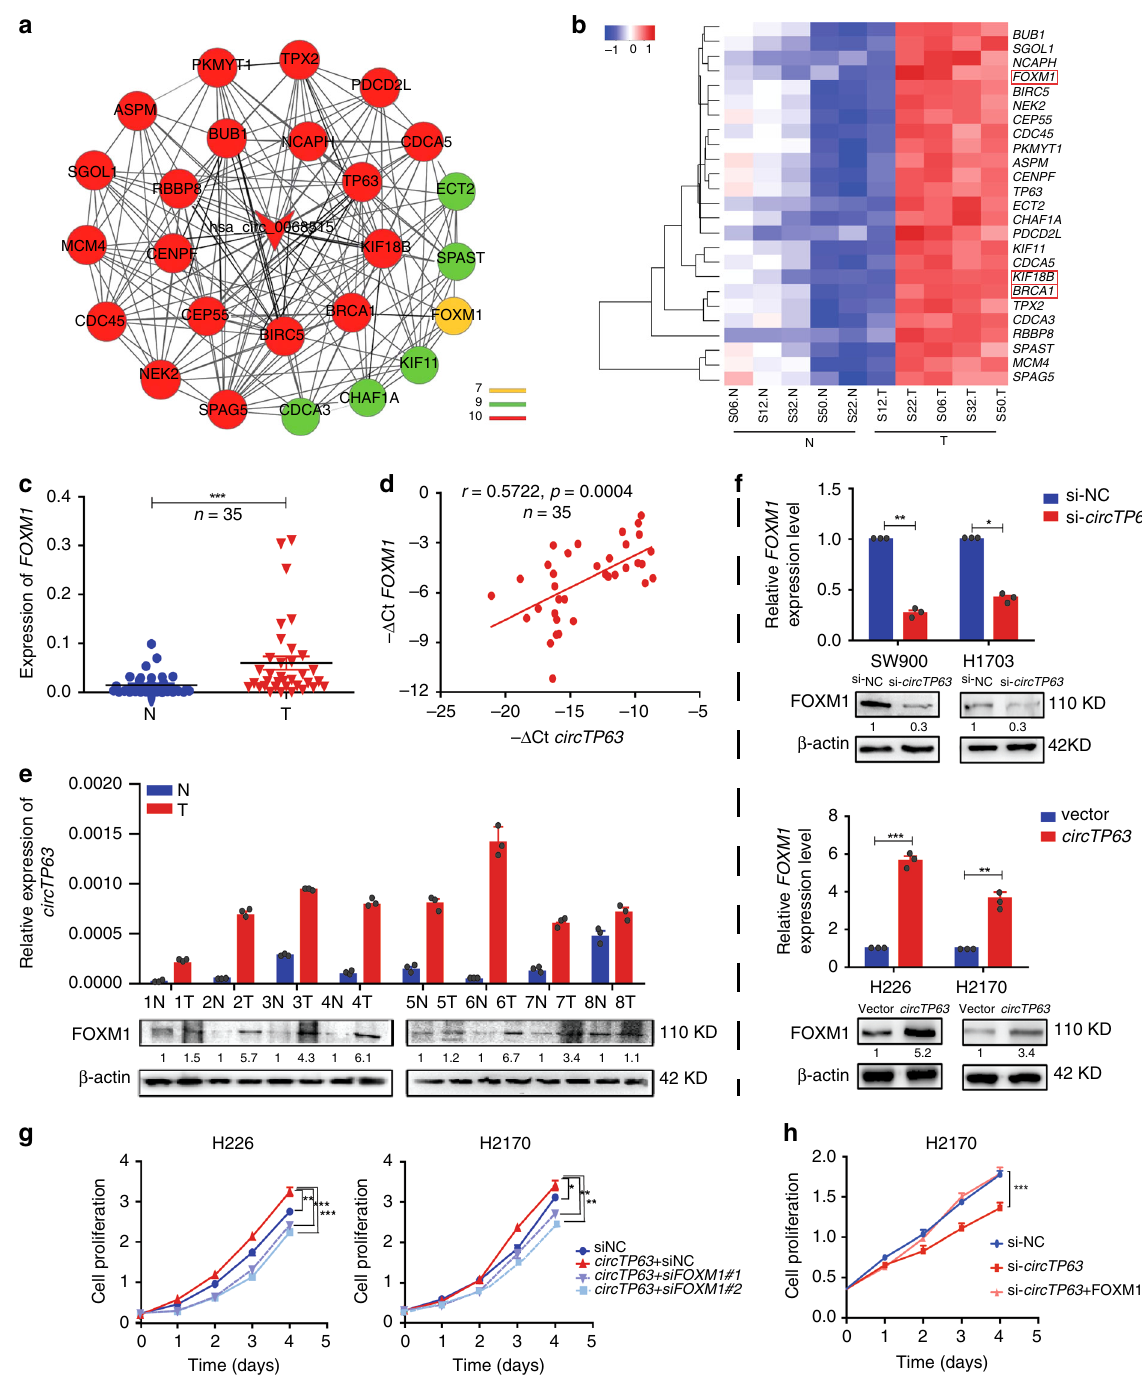
Fig. 4 c ircTP63 contributes to cell proliferation through targeting FOXM1. a Co-expression network of circTP63 with associated 25 mRNAs. A round node represents a protein-coding gene and the arrow node represents circTP63 ( hsa_circ_0068515 ). Lines between two nodes indicate interactions between two genes. Color represents the number of lines. b A heatmap shows mRNA levels of these 25 co-expression genes in the fi ve paired LUSC samples of SBC Human ceRNA Array analysis. c Expression analysis for FOXM1 in additional 35 paired LUSC samples. d Correlation analysis revealed positive correlation between the levels of circTP63 and FOXM1 mRNA in the tumorous tissues of the 35 LUSC patients. Δ Ct values were normalized according to β -actin . e The levels of circTP63 expression and FOXM1 protein in eight paired LUSC samples. f The mRNA and protein levels of FOXM1 in the LUSC cells with knockdown or overexpression of circTP63 . g Cell proliferation assay for H226 and H2170 cells with circTP63 overexpression and FOXM1 knockdown. h Cell proliferation assay for H1703 cells with circTP63 knockdown and FOXM1 overexpression. The error bars c , e – h represent s.d. (in c , n = 35; in e – h , n = 3). * p < 0.05; ** p < 0.01; *** p < 0.001, two-tailed t -test. Source data are provided as a Source Data fi